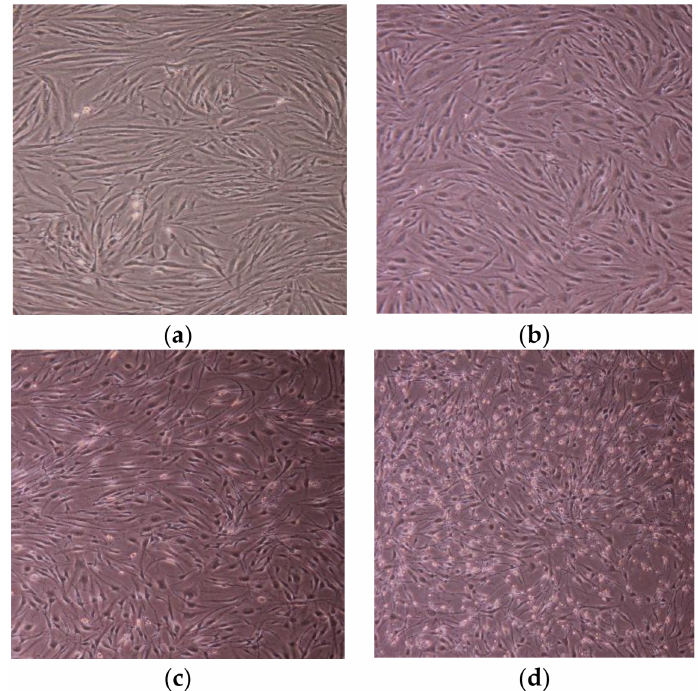
Figure 15. HSF cell growth in the ( a ) extraction medium and on the surface of the ( b ) Ti (uncoated) sample, ( c ) TiV coating, and ( d ) 100 kHz LSTO Ti-V-O